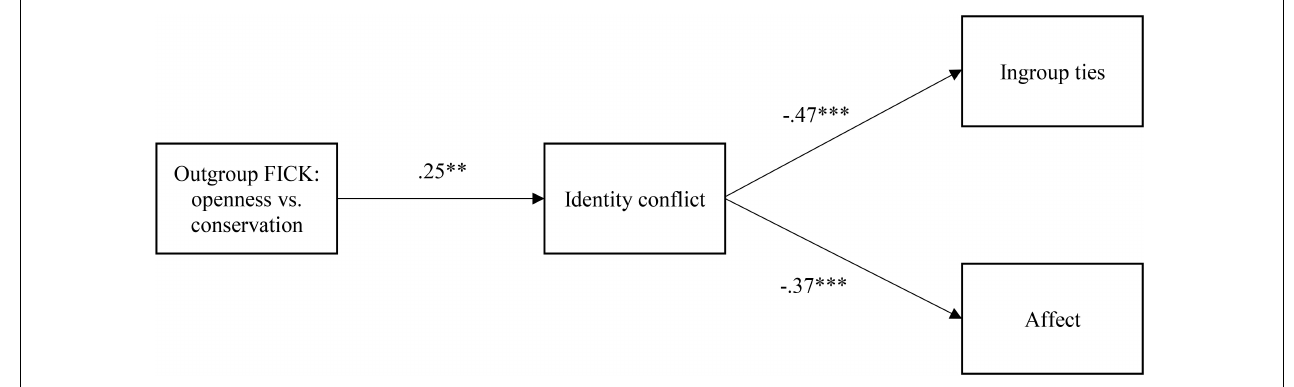
FIGURE 2 | The path model depicting how outgroup FICK in openness to change versus conservation affects Chinese identification via identity conflict (Study 1). FICK, fit in cultural knowledge. Numbers represent standardized regression coefficients. ∗∗ p < 0.01, ∗∗∗ p <